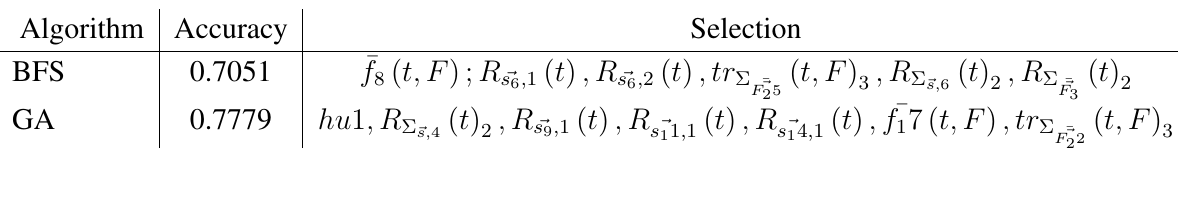
Table 7. Features found by by Best First Search (BFS) and Genetic Algorithm(GA) for classificating six activities